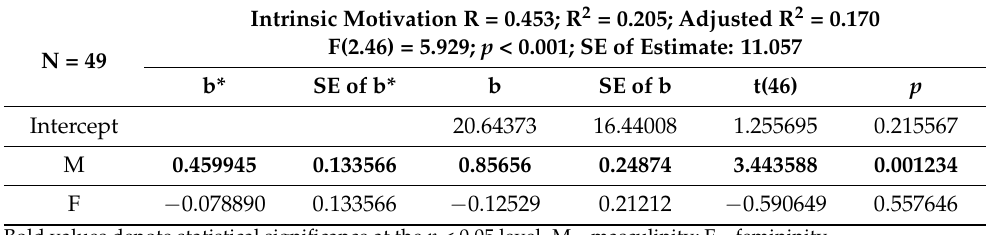
Table 3. Multiple regression explaining variation in intrinsic motivation based on psychological femininity and masculinity in the group of women